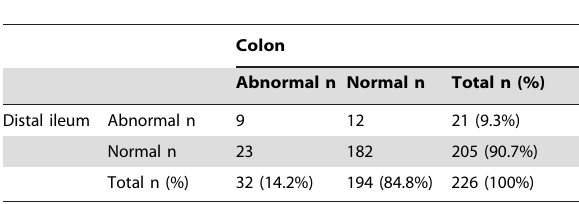
Table 1. Colonoscopic